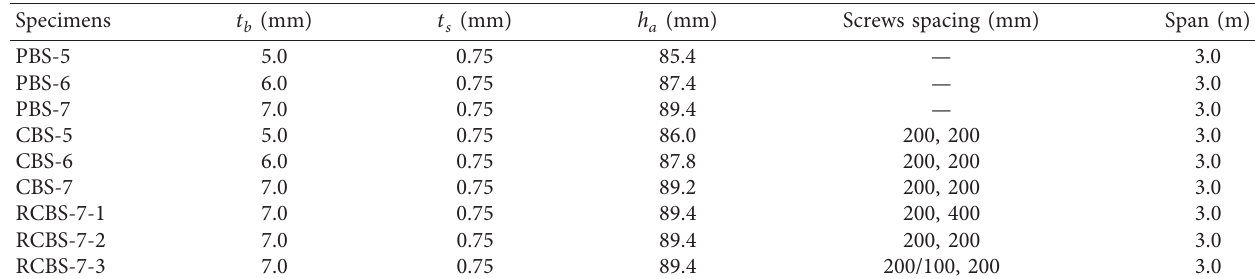
Figure 2: Methods of connection. (a) PBS. (b) CBS. (c) Table 1: Detail of test specimens.